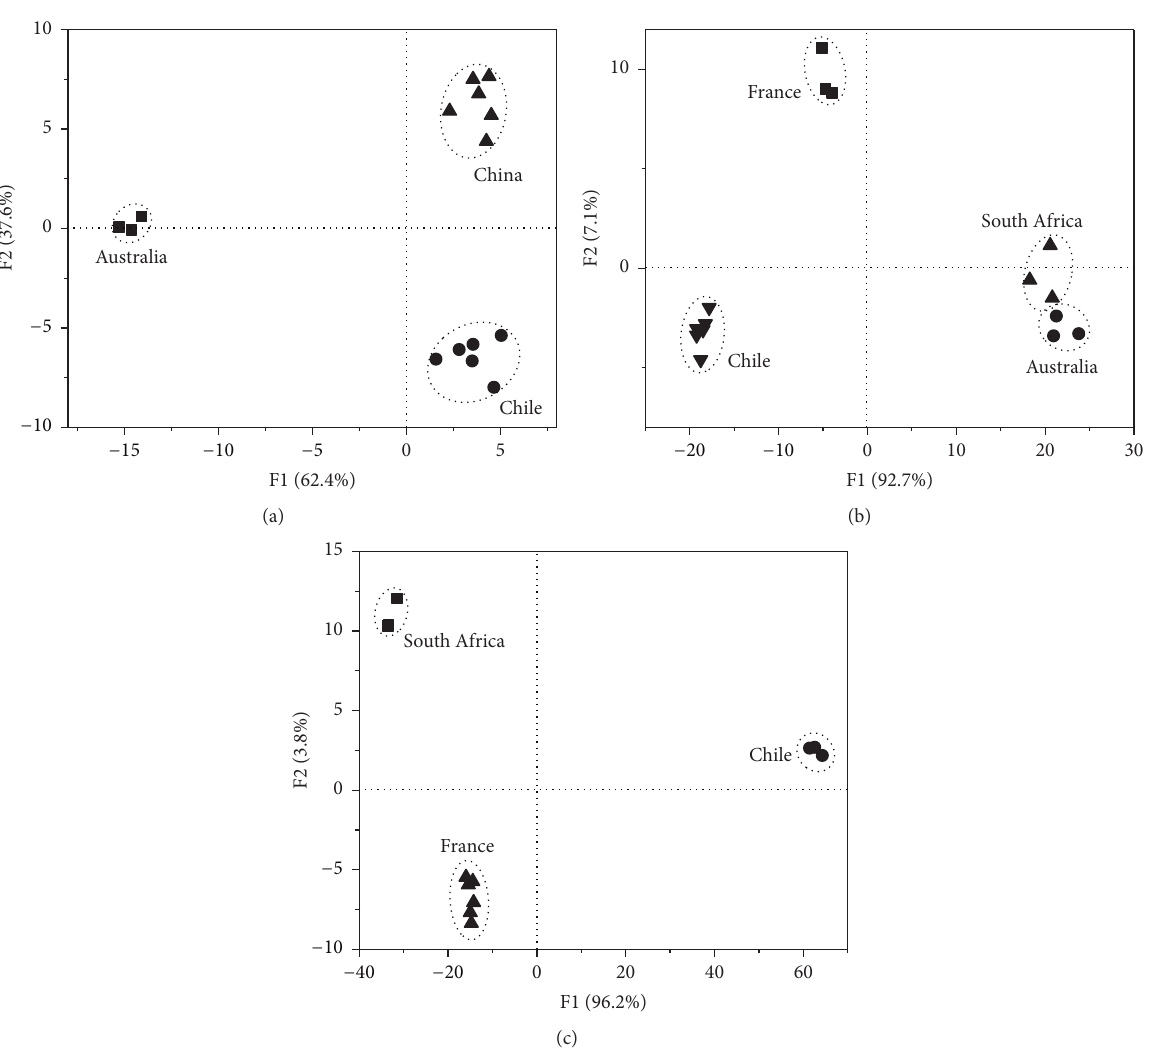
Figure 4: LDA plots for the geographical identification based on the organic acid profiles. Grape variety: Cabernet Sauvignon (a), Merlot (b), and Shiraz